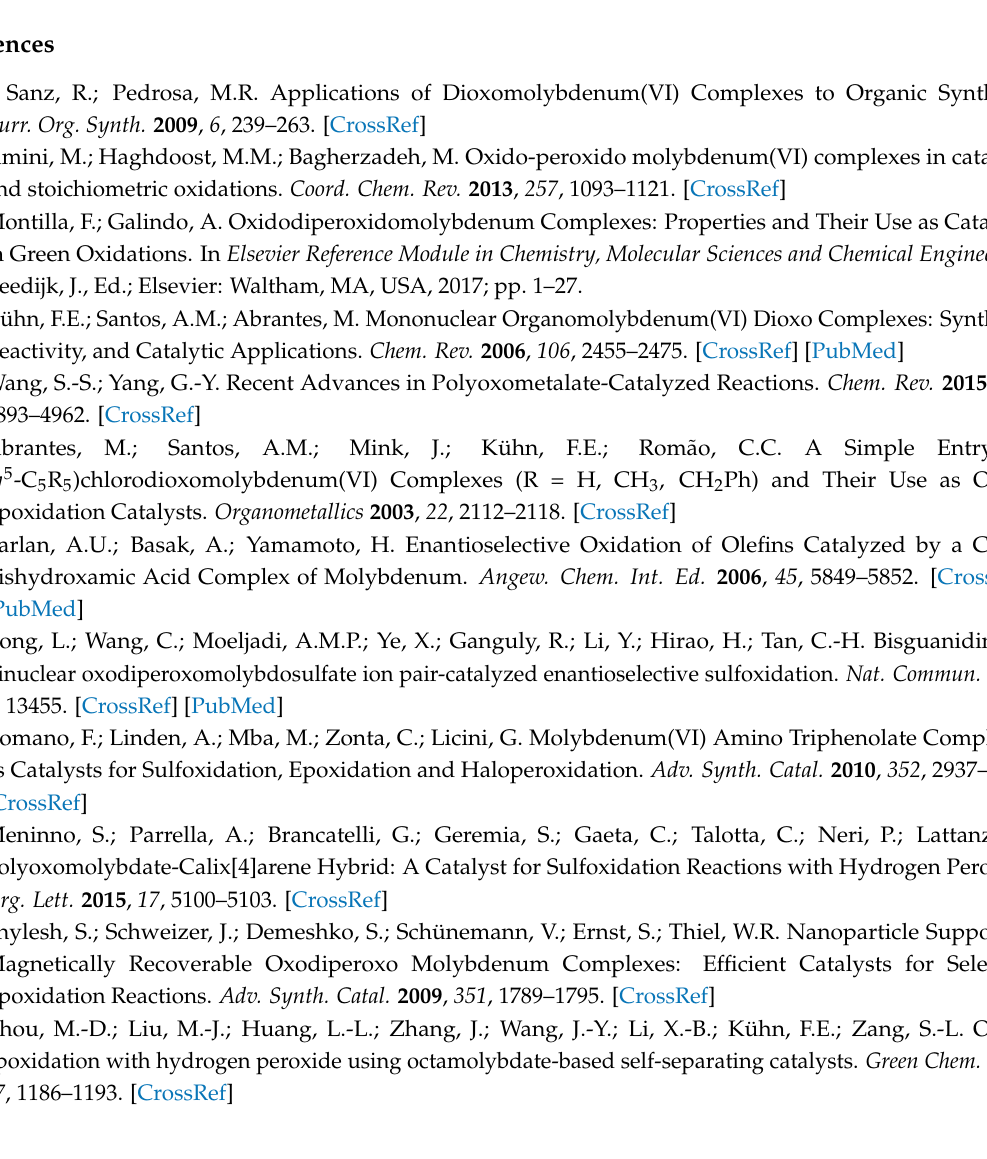
Supplementary Materials: The following are available online. Figure S1: TGA curves for 1 , 2 , 1 OD , 3 and 5 , Figure S2: Raman spectrum of 5 , Figure S3: ATR FT-IR spectra of 1 OD , 1 ODr , 1 r , 2 OD , 2 ODr , 2 r , 3 , 3 r , 4 and 4 r , Figure S4: Computed and experimental PXRD patterns of 3 , 4 and 5 , Figure S5: 1 H NMR spectrum of 1 , Table S1: Selected bond distances and angles for the molecular structure of 5